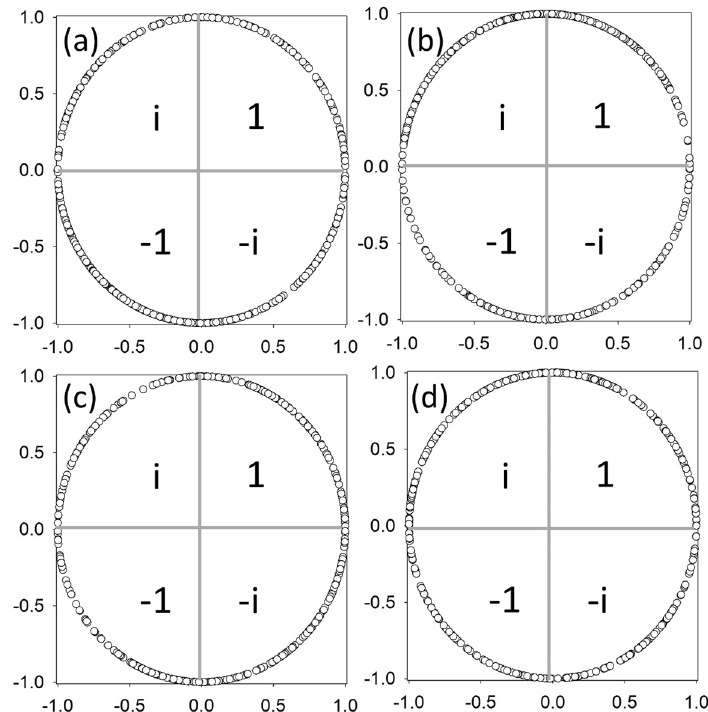
ij ij ij 11 , ( b ) C 12 , ( c ) C 21 ,